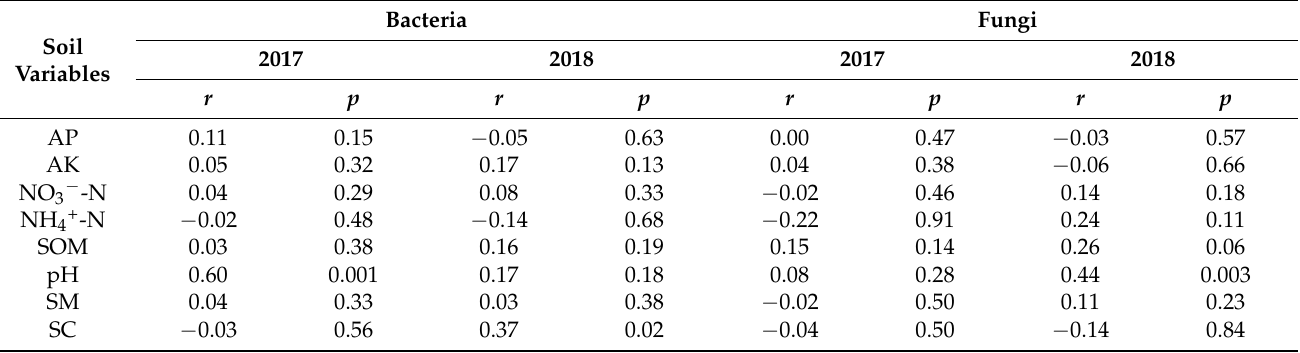
Table 1. Mantel tests of the soil bacterial and fungal communities’ compositions with soil variables in 2017 and